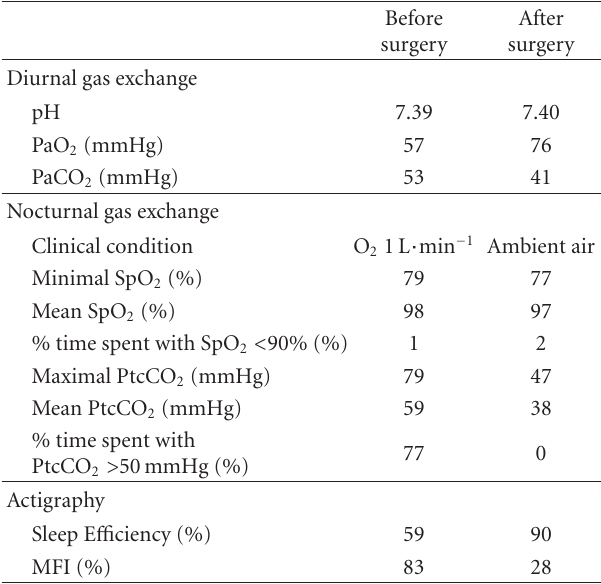
Table 1: Diurnal and nocturnal gases exchanges and sleep actigra- phy before and 2 months after